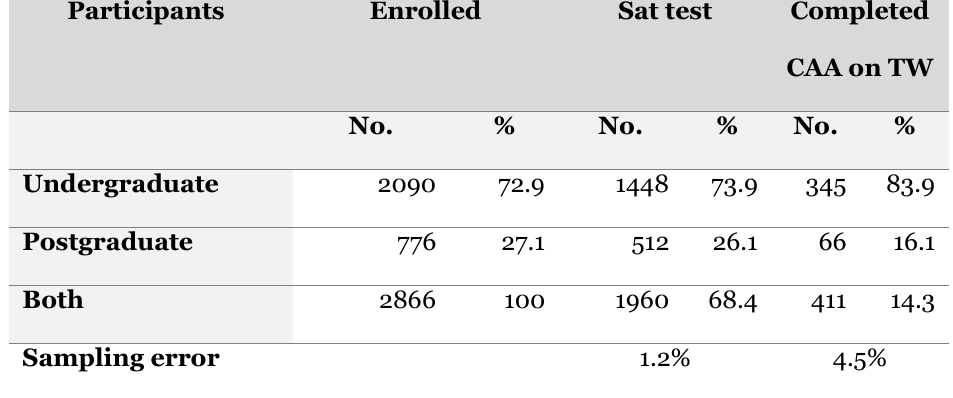
Study Population and